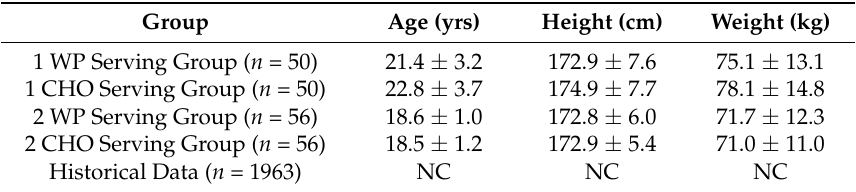
Table 1. Summary of participants’ descriptive statistics.